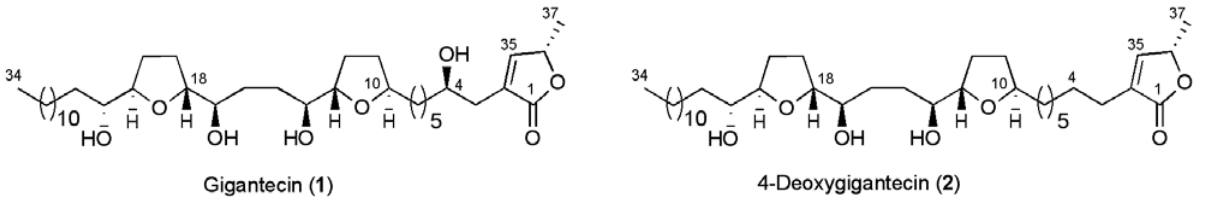
Figure 2. Structures of non-adjacent bis-THF acetogenins gigantecin ( 1 ) and 4-deoxygigantecin ( 2